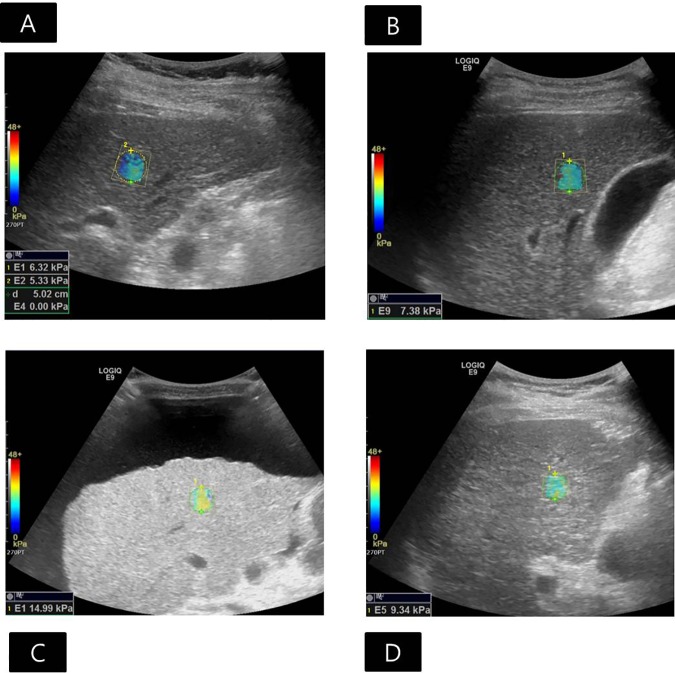
When applying the cutoff values from our study, the live stiffness (LS) values obtained by the 2D comb-push shear wave elastography (2D CP-SWE) could predict histologic fibrosis staging.A)The median LS value of 5.98kPa was achieved by the 2D CP-SWE in a 64-year-old man, which was greater than the cutoff value of F2 (5.33kPa) and less than the cutoff value of F3 (6.84kPa). The patient underwent surgical resection for hepatocellular carcinoma (HCC), after which the fibrosis staging was histologically confirmed to be F2. B) The median LS value of 7.38kPa was measured by the 2D CP-SWE in a 66-year-old man, which was greater than the cutoff value of F3 (6.84kPa) and less than the cutoff value of F4 (7.59kPa). The patient underwent surgical resection for HCC, after which the fibrosis stage was histologically confirmed as F3. C) Despite massive ascites, reliable LS values were successfully measured by 2D CP-SWE in a 57-year-old woman. The median LS value of 13.45kPa was greater than the cutoff value of F4 (7.59kPa). The patient underwent liver transplantation. The fibrosis stage was histologically proven to be F4, and the macronodular cirrhosis was associated with alcohol consumption. D) Reliable LS values were successfully measured by 2D CP-SWE in a 49-year-old obese man with a body mass index of 31.33kg/m2. The median LS value of 8.14kPa was greater than the value of F4 (7.59kPa). The patient underwent liver transplantation. The fibrosis stage was histologically proven to be F4, and macronodular cirrhosis was associated with hepatitis B virus infection and alcohol consumption.